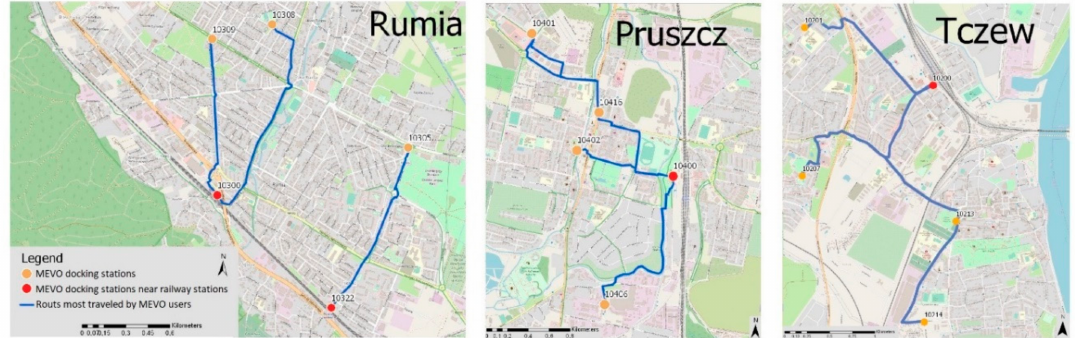
Figure 7. The most popular routes taken by Mevo users in the chosen peripheral municipalities. Source: